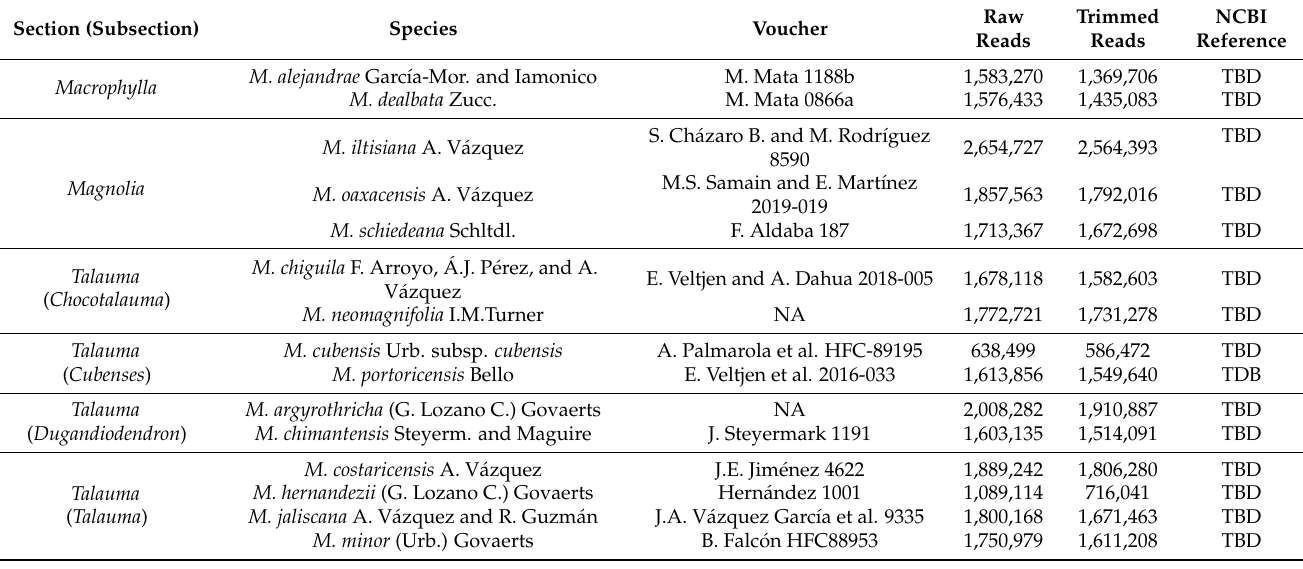
Table A1. Sequencing results of the newly assembled Magnolia species. Columns show the number of paired raw reads, the number of paired reads after quality trimming with Trimmomatic, and the NCBI reference number. NA = Not applicable.